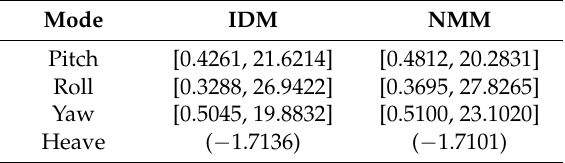
Table 6. Hover eigenvalues in the updated NMM compared with